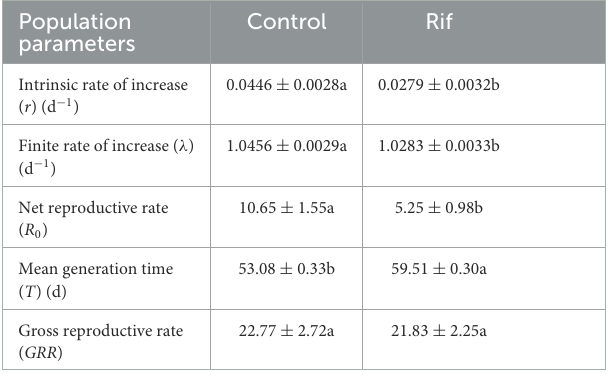
TABLE 5 Population parameters (means ± SE) of A. camelliae in the control and the rif-treatment calculated by using the age–stage, two-sex life